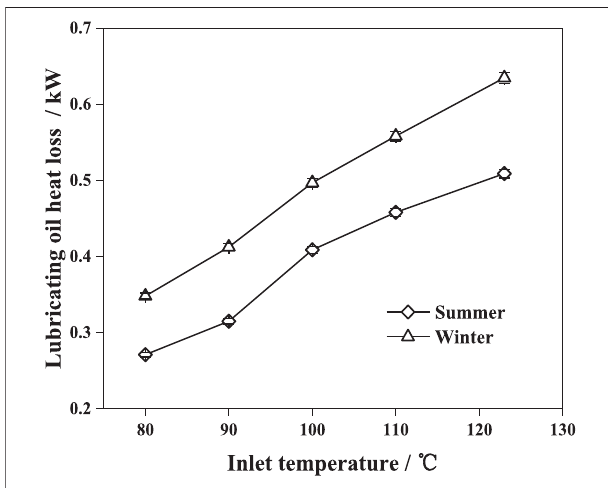
FIGURE 9 | The variation of the lubricating oil heat loss with inlet temperature.